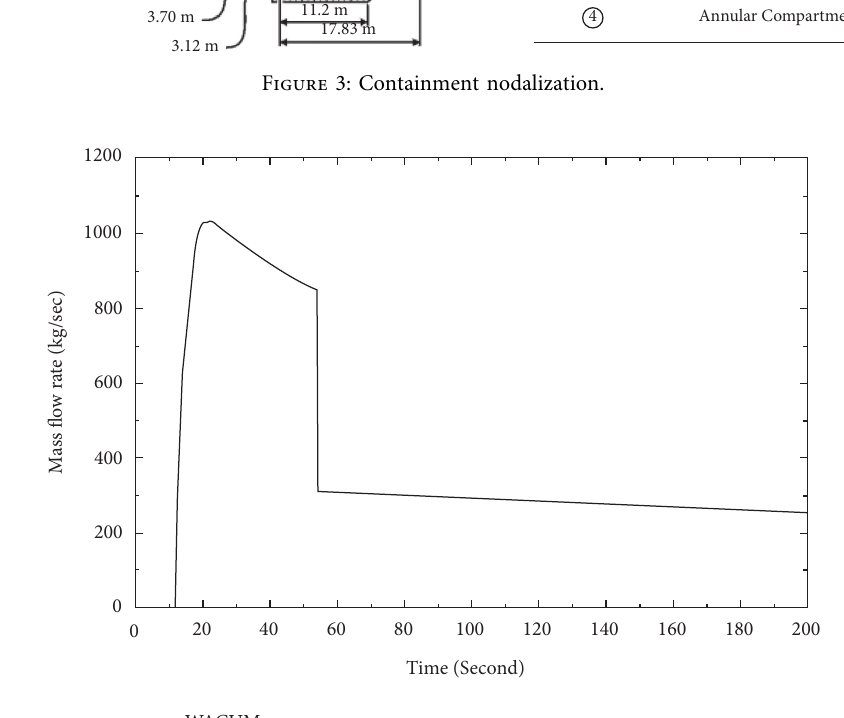
Figure 4: Simulated SIT mass flow rate.